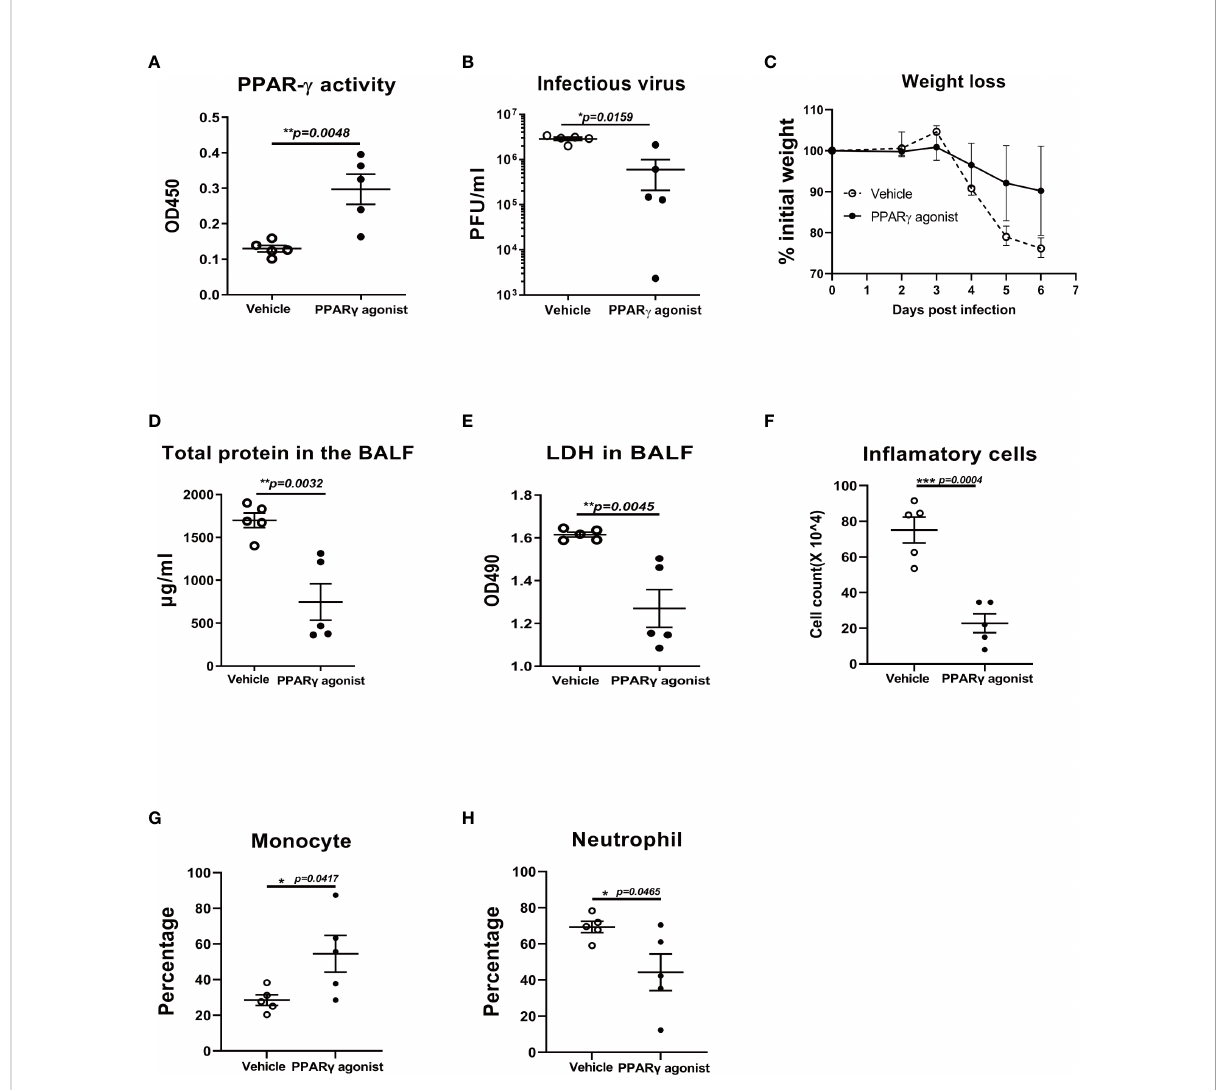
FIGURE 5 PPAR g agonist reduces viral replication and virus-induced weight loss in in fl uenza virus-infected mice. C57B/6 mice were treated with PPAR g agonist troglitazone prior to in fl uenza infection and evaluated viral burden, weight loss, and in fl ammatory cell differentiation in bronchoalveolar lavage fl uid (BALF) and acute lung injury. Compared to the vehicle control-treated group, troglitazone-treated mice displayed elevated PPAR g activity (A) , reduced viral burden (B) and attenuated weight loss (C) . There was a signi fi cantly decreased total protein (D) and LDH (E) , reduced total cell number (F) , reduced percentage of neutrophils (G) , and an increased percentage of monocytes in the infected BALF (H) . Unpaired t test was applied for statistical analysis. *p < 0.05, **p < 0.01, and ***p <